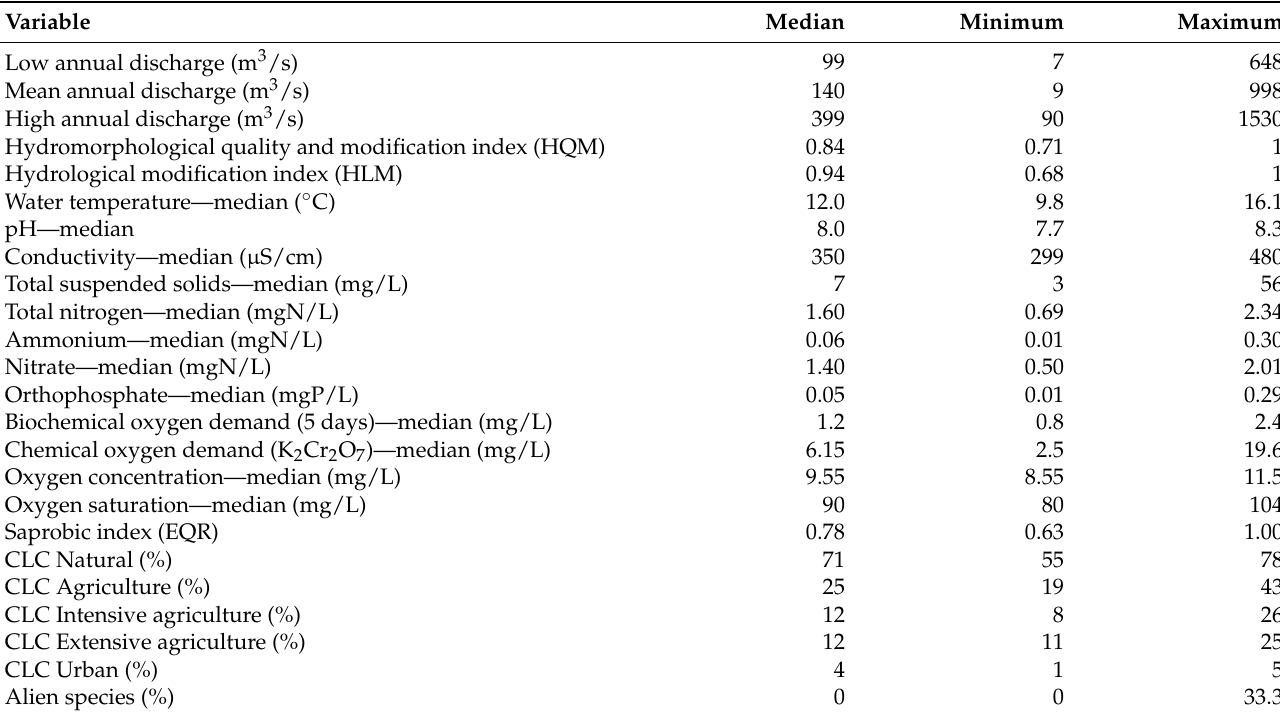
Table 2. Median, minimum and maximum values of the selected hydromorphology, water quality, land use variables and proportion of alien species at near-natural